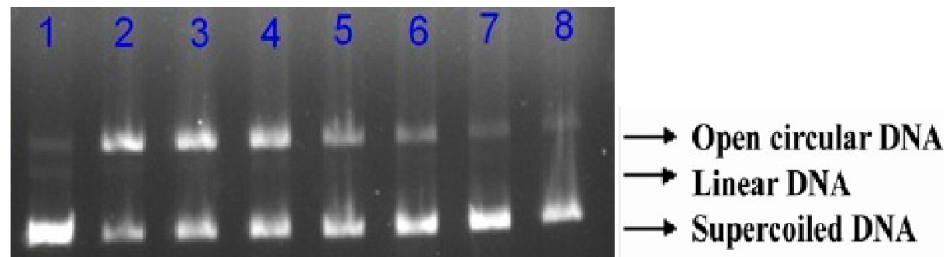
Figure 4. Protection of RPP with different concentrations on 2,2-azobis-2-methylpropion-amidine dihydrochloride (AAPH)-induced supercoiled plasmid DNA strand breakage. Lanes: 1, control (DNA only); 2, DNA + AAPH; 3–4, DNA + AAPH + RPP of 20 μ g/mL; 5–6, DNA + AAPH + RPP of 40 μ g/mL; 7–8, DNA + AAPH + RPP of 60 μ g/mL.